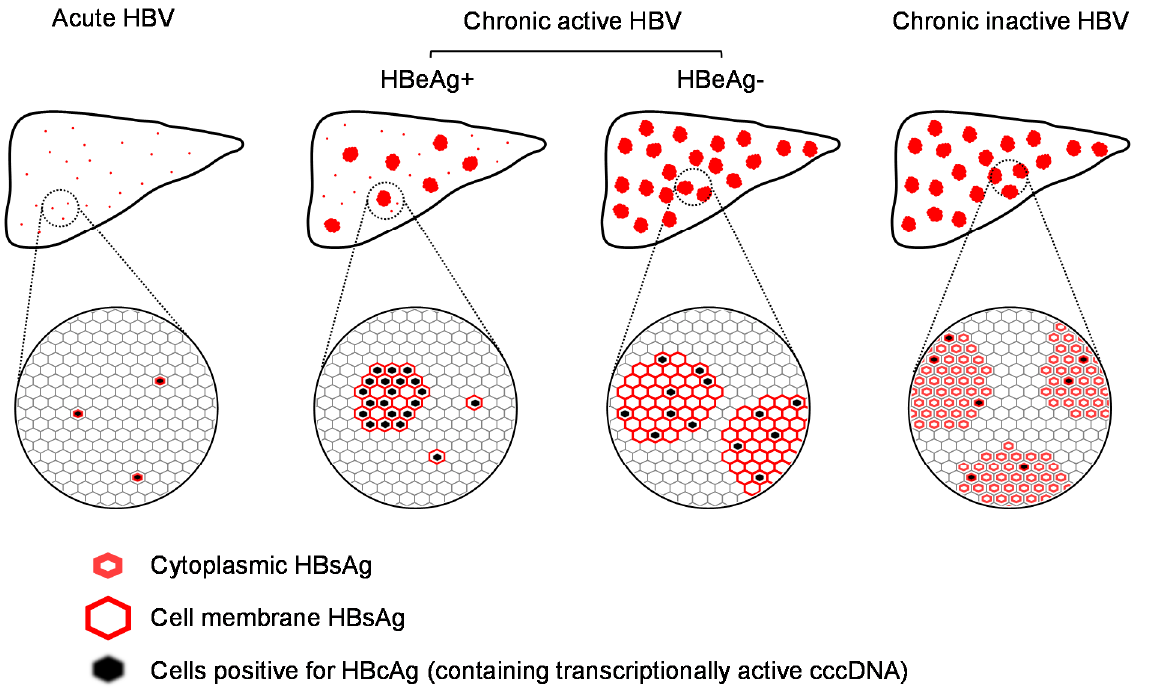
Figure 1. Distribution of infection in the liver during the course of HBV infection.